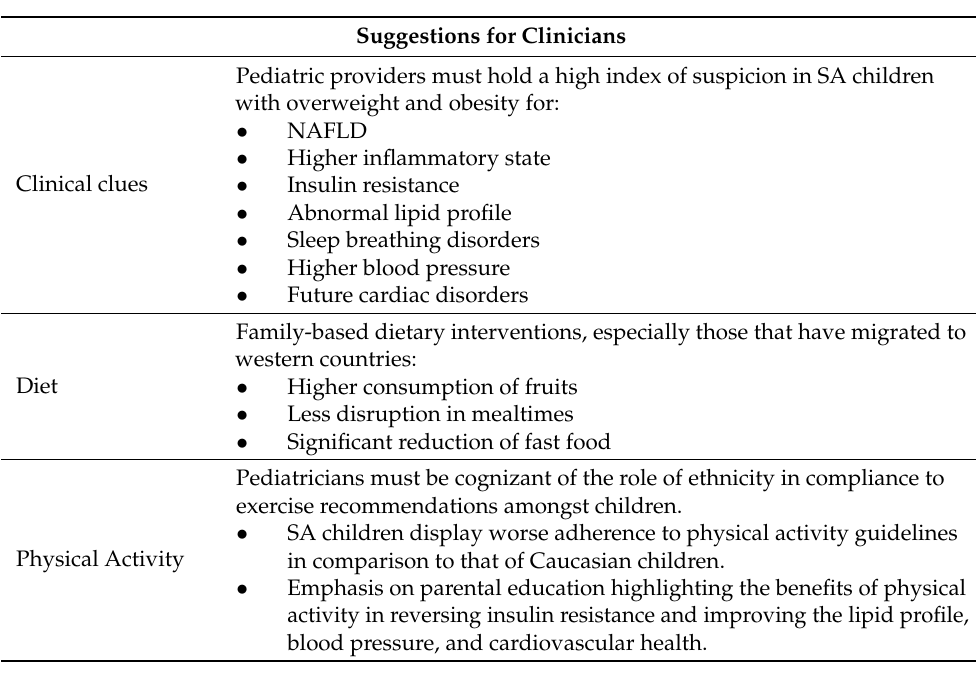
Table 4. Suggestions for clinicians managing SA children with